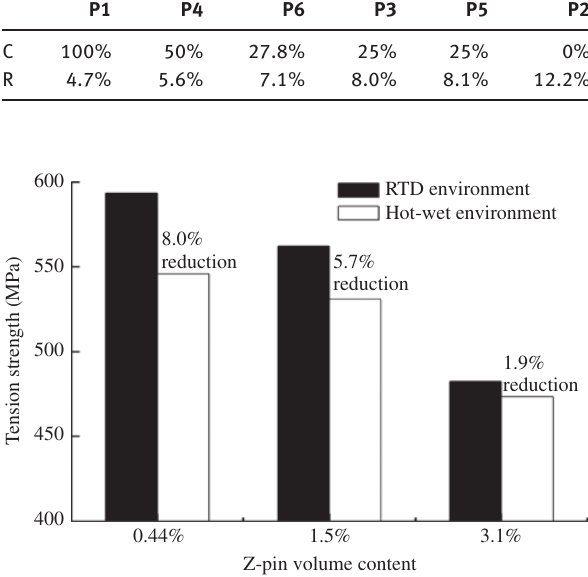
specimens with differ- 2S